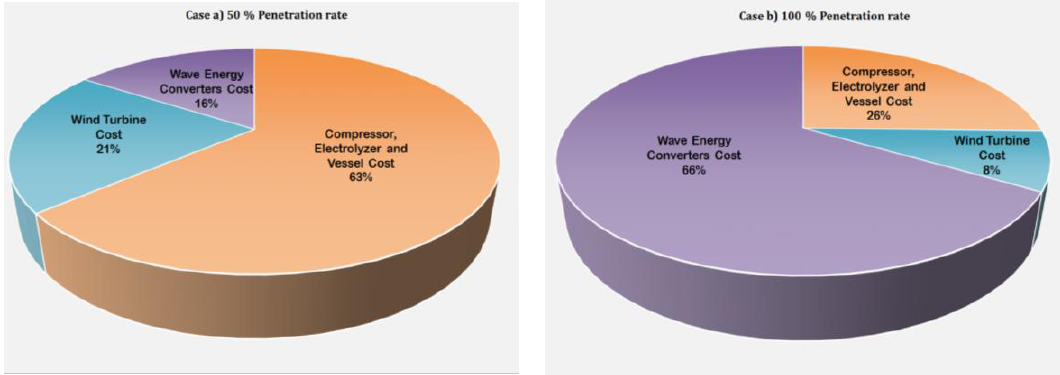
Figure 10. Economical results for the first and third scenarios.